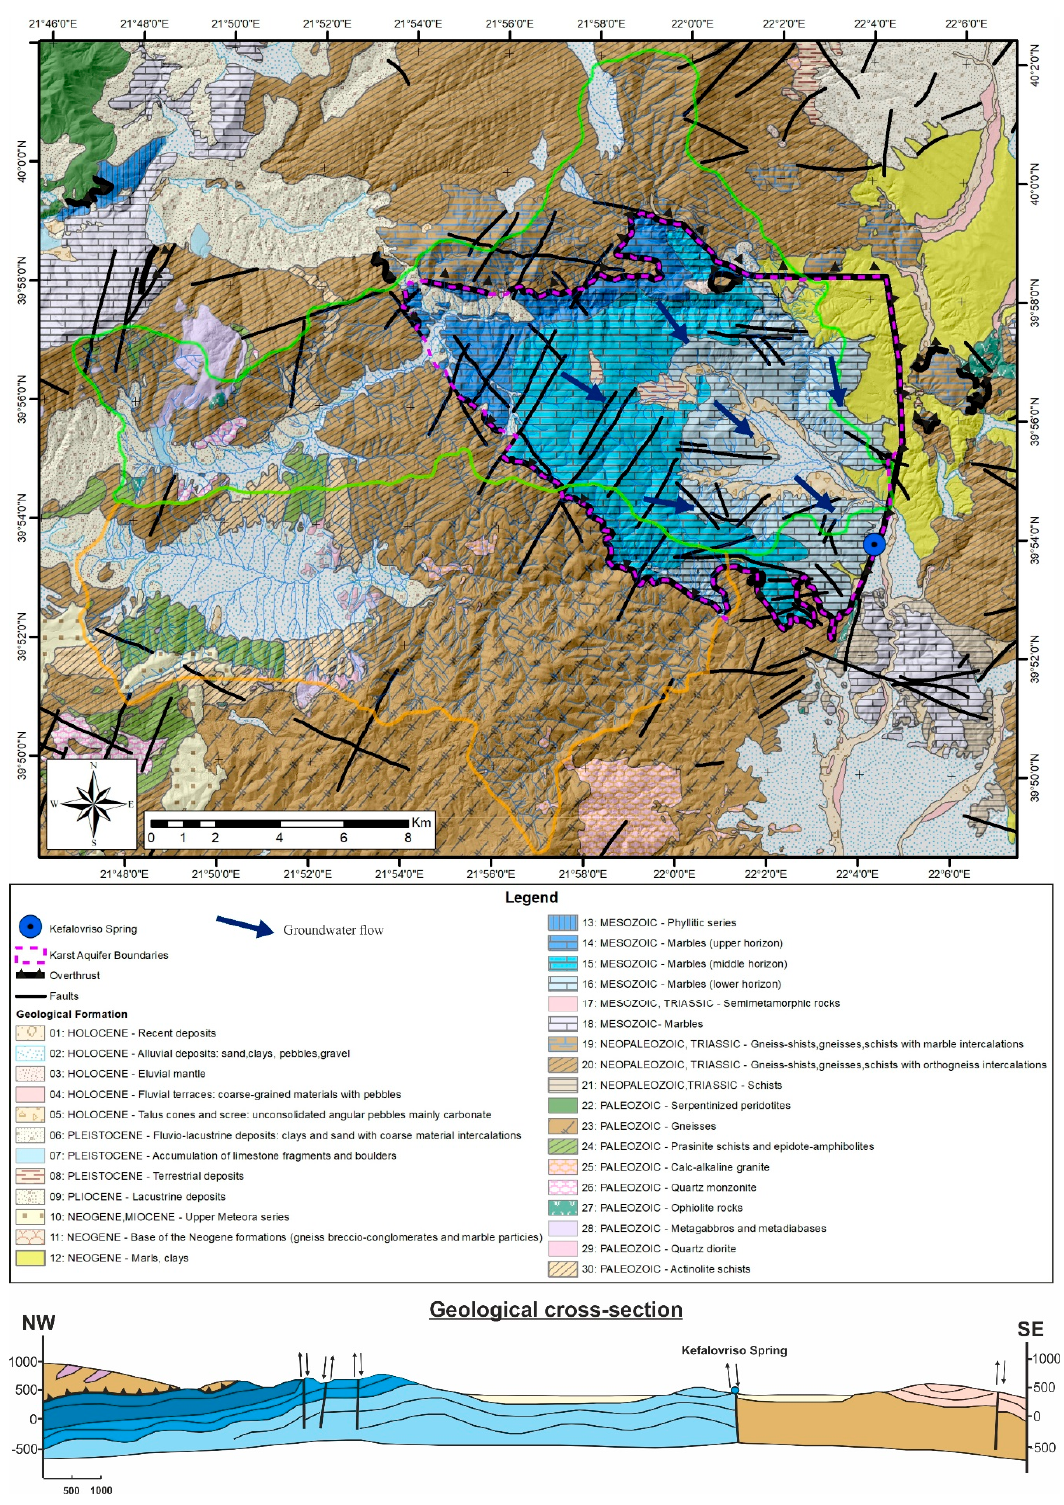
Figure 2. Geological map of the study area.